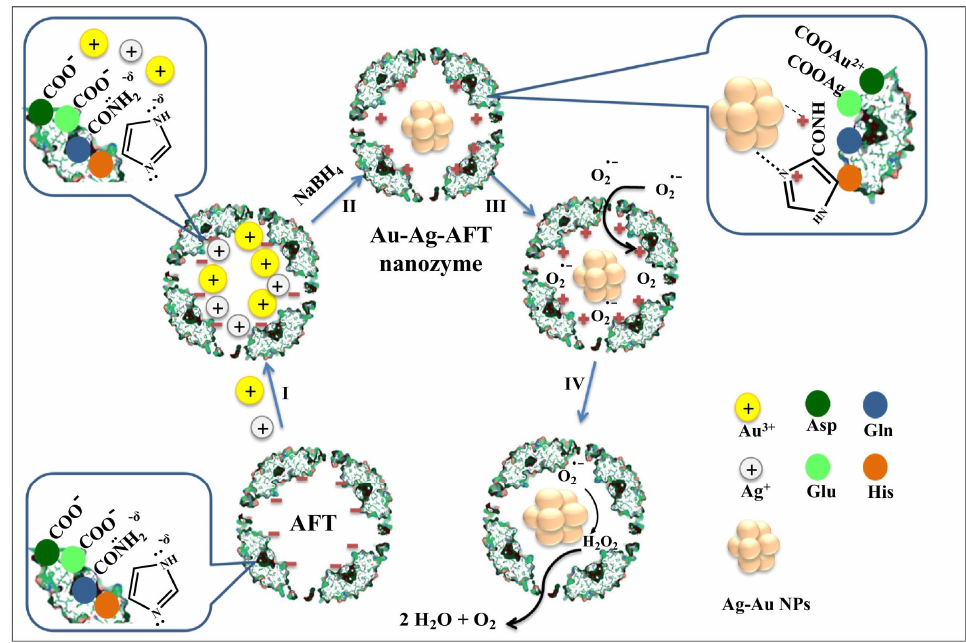
Figure 15. Ft–Au–Ag nanozyme synthesis procedure and O 2 ∙− scavenging and H 2 O 2 reduction by the triple enzyme ‐ like activity of the proposed nanozyme. Reprinted with permission from [60]. Copyright © 2019 Elsevier.